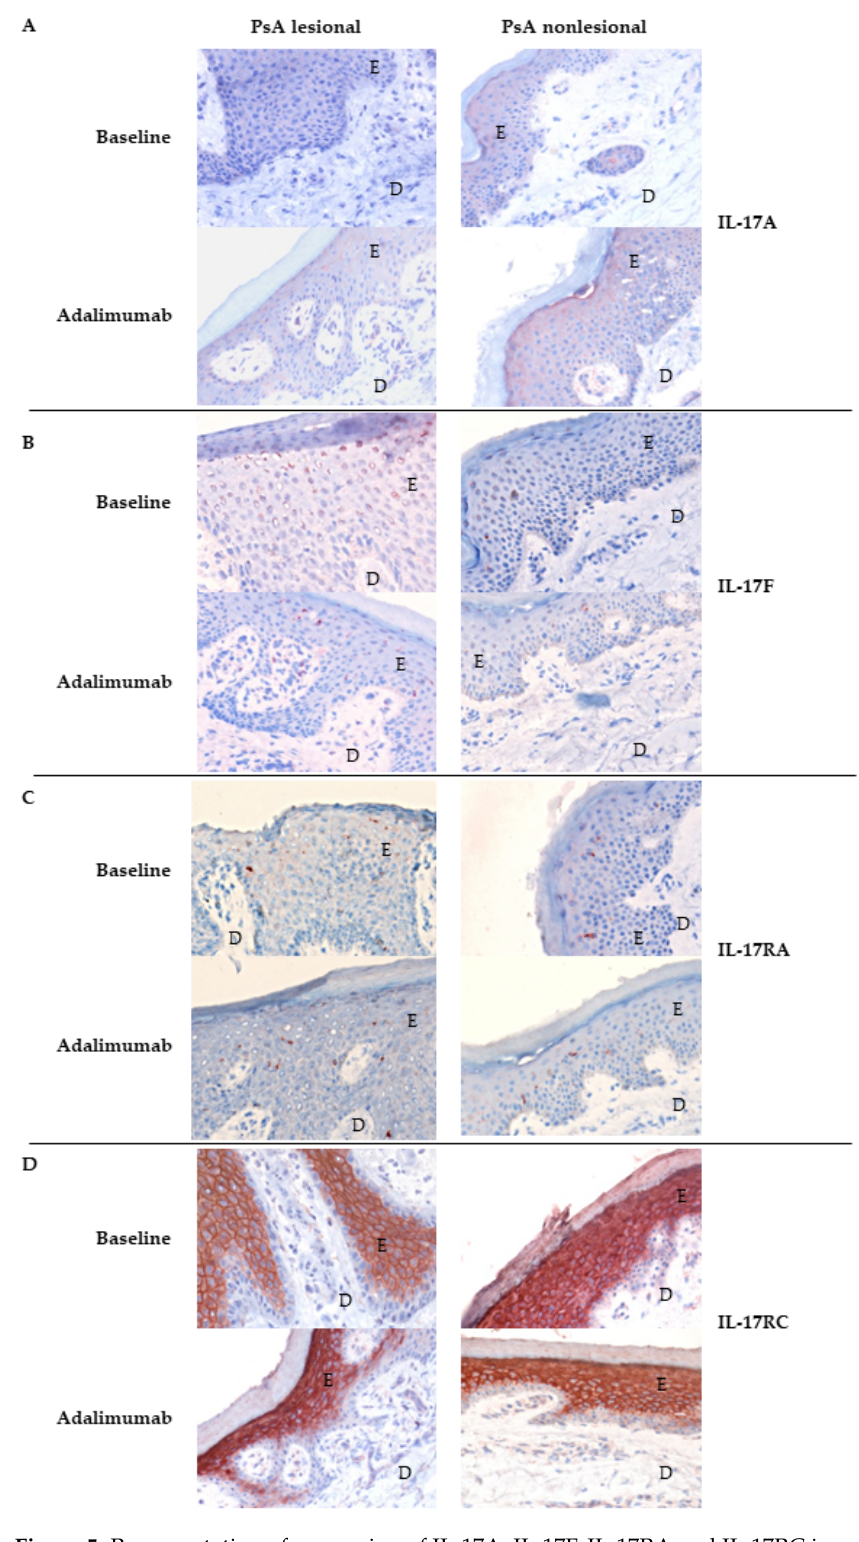
Figure 5. Representation of expression of IL-17A, IL-17F, IL-17RA and IL-17RC in psoriatic skin of one PsA patient before and after adalimumab treatment. Expression was not altered after 4 weeks of adalimumab. Representative immunohistochemical staining of IL-17A ( A ), IL-17F ( B ), IL-17RA ( C ) and IL-17RC ( D ) expression in skin of one PsA patient before (baseline) and after treatment with adalimumab. Original magnification 200 × . E; epidermis, D; dermis, IL, interleukin; PsA, psoriatic